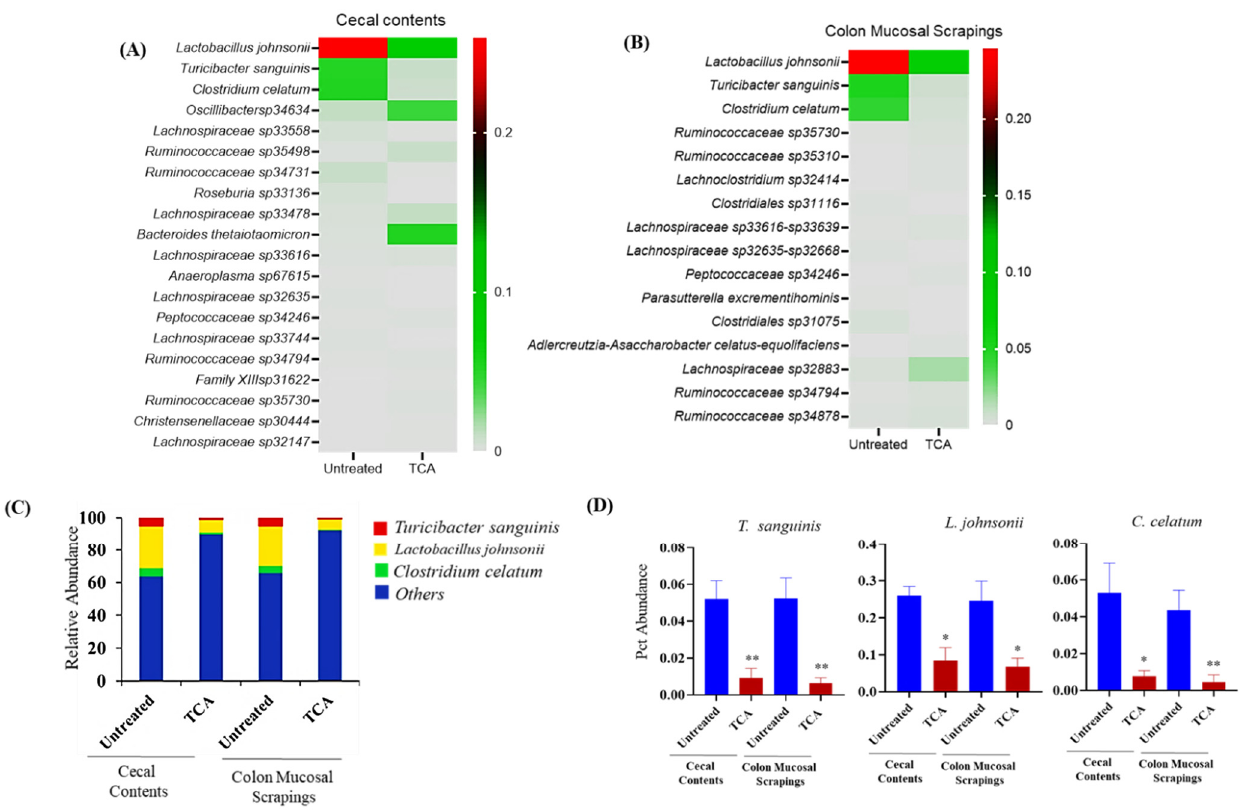
Figure 6. TCA alters the relative abundance of intestinal microbiota . C57BL/6 mice were infected with ~2 × 10 8 CFU CA SC5314 via oral gavage. Control mice received sterile drinking water (untreated group); the treatment group received sterile water containing 1% TCA (TCA group). Ten days post-infection, cecal contents and colon scrapings were collected to determine the relative abundance of intestinal microbiota. ( A , B ) Bacterial members that are significantly altered in the TCA group compared to the untreated control groups in cecal content and colon mucosal scrapings, respectively, are shown here. ( C , D ) Bacterial members that are significantly altered in the TCA group compared to the untreated control groups in both cecal content and colon mucosal scrapings are shown here. Five mice per group were used. Data represent mean ± SEM. Statistical significance was evaluated using the Student’s t -test. p values ≤ 0.05 (*) or ≤ 0.01 (**) were considered statistically significant.